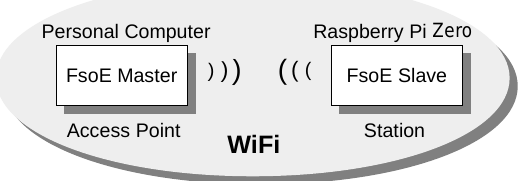
Figure 4. Scheme of the Experimental Setup.